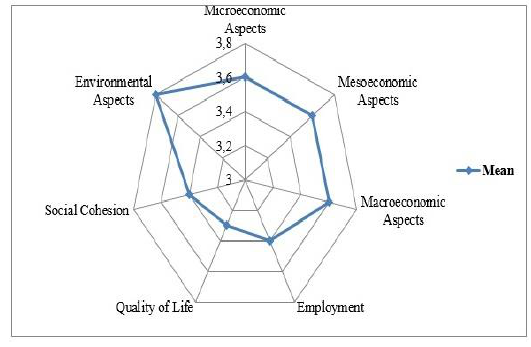
Figure 1. Overall Socioeconomic